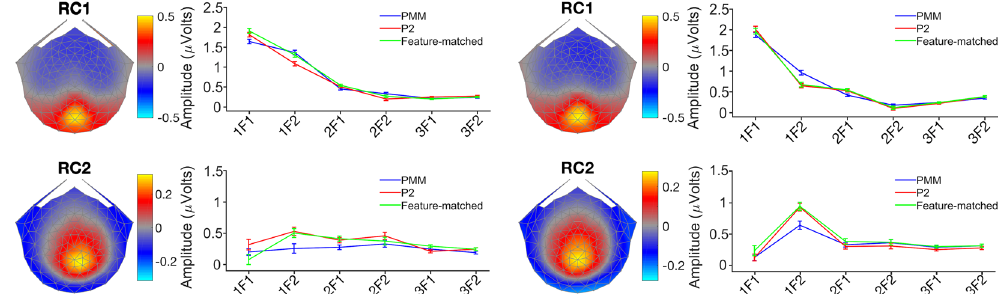
Figure 3. The RC topographies of self-terms and amplitude of two frequency pairs. The left column represents the first frequency pair, while the right column represents the second frequency pair. Rows represent two RCs. The first row shows topographies and amplitude values of RC1 from both frequency pairs. The second row shows topographies and amplitude values of RC2 from both frequency pairs. Error bars indicate the standard error of the